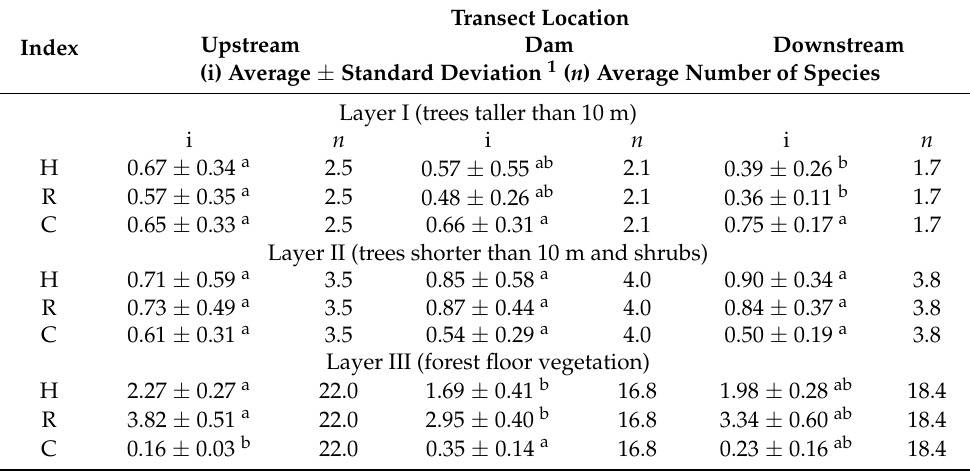
Table 4. Indicators of species diversity of forest layers related to distance from beaver dams. Average variation was determined for an area of 108 m 2 (3 measurement plots).